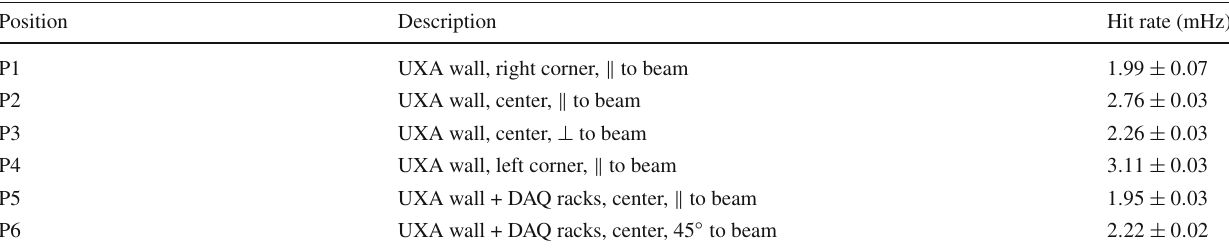
Fig. 27 Hit rates during the run based on the six P1–P6 positions/configurations on a linear (top) and log (bottom) scale. Red data points denote the luminosity rate of LHCb, blue and green data points denote hit rates. Figure reproduced from Ref. [191] Table 4 Background hit rates based on each position/configuration with no beam. Table reproduced from Ref. [191] Position